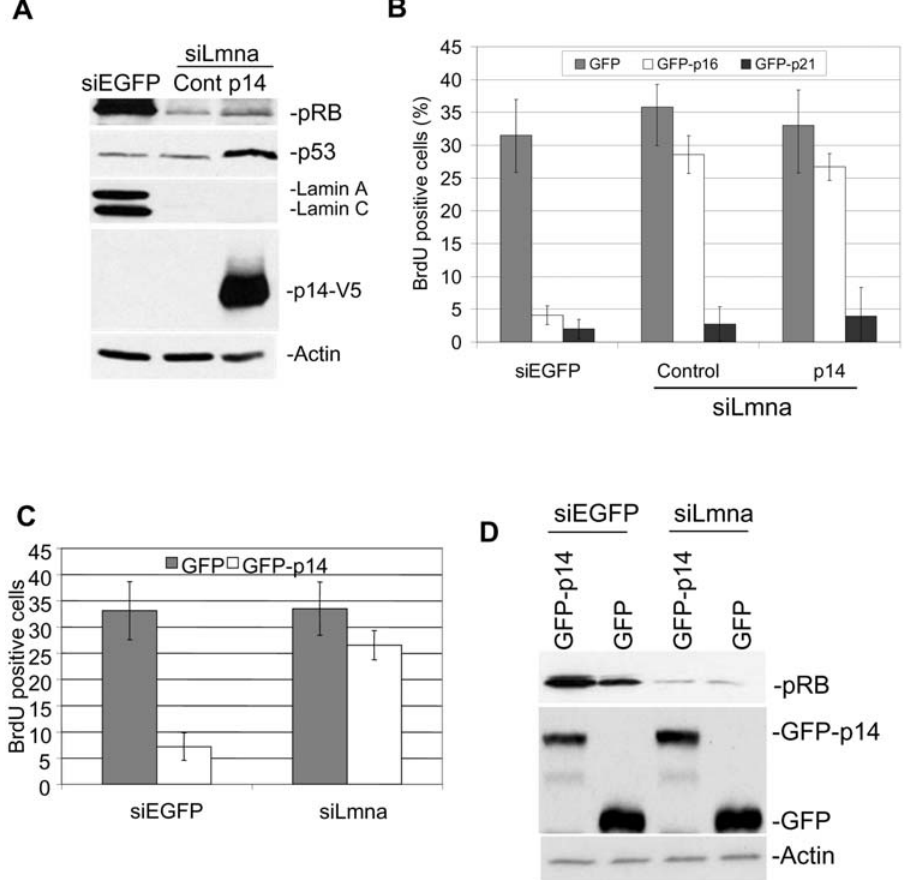
Figure 5. Expression of p14 arf in siLmna cells does not restore pRB levels or p16 ink4a sensitivity. NIH3T3 siLmna cells were stably transduced with a V5 tagged p14arf (siLmna-p14) or an empty vector (siLmna-Cont). (A) Western blot analysis comparing pRB levels in siEGFP cells, siLmna-Cont, and siLmna-p14. (B) Cells were transfected with GFP-p16ink4a or GFP-p21cip1 and the S-phase cells were identified by BrdU incorporation. The percentage of cells positive for GFP and BrdU incorporation were quantified. (C) siEGFP and siLmna cells were transfected with GFP-p14arf and the S-phase cells were identified by BrdU incorporation. (D) siEGFP and siLmna cells were transfected with GFP-p14arf and the GFP positive cells were sorted using FACS